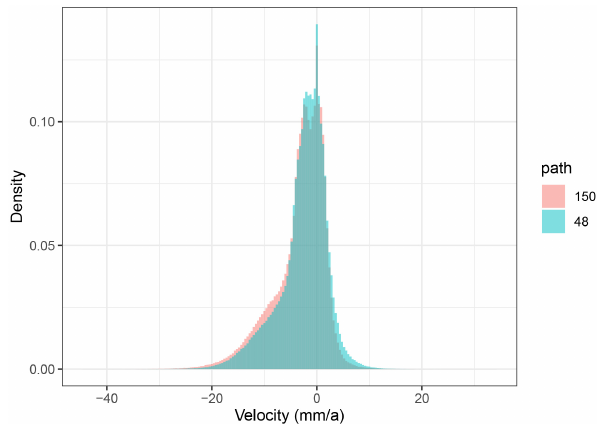
Figure A4. The distribution of long-term velocity values in the satellite LOS direction from orbit 48 and orbit 150 in their over- lapping